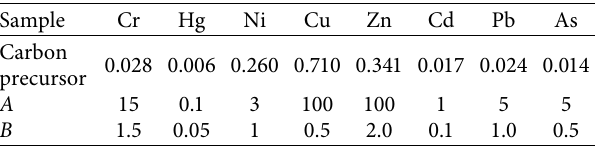
Table 2: Extraction toxicity of heavy metals in the carbon precursor (mg/L).